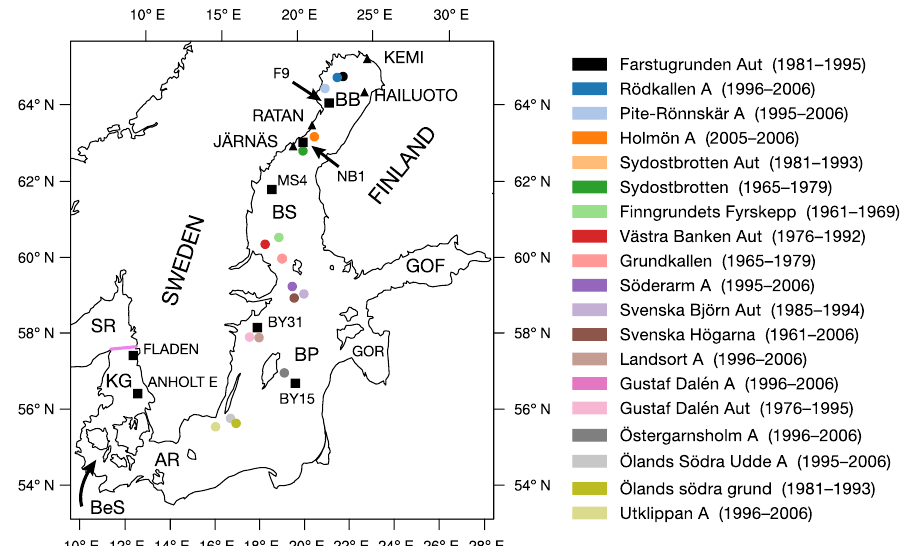
Figure 1. Map showing names of places mentioned in the text; the sub-basins are abbreviated. BB: Bothnian Bay; BS: Bothnian Sea; GOF: Gulf of Finland; GOR: Gulf of Riga; BP: Baltic proper; GR: Gulf of Riga; KG: Kattegat; AR: Arkona Sea; BeS: Belt Sea; and SR: Skagerrak. The pink line shows the open boundary in Kattegat; the black triangles show the coastal sites Hailuoto, Kemi, Ratan, and Järnäs; and the black squares show the Fladen, Anholt E, BY15, BY31, MS4, NB1, and F9 stations. The air temperature stations are depicted by the dots color coded according to the legend to the right; the time period for each air temperature station is shown within the